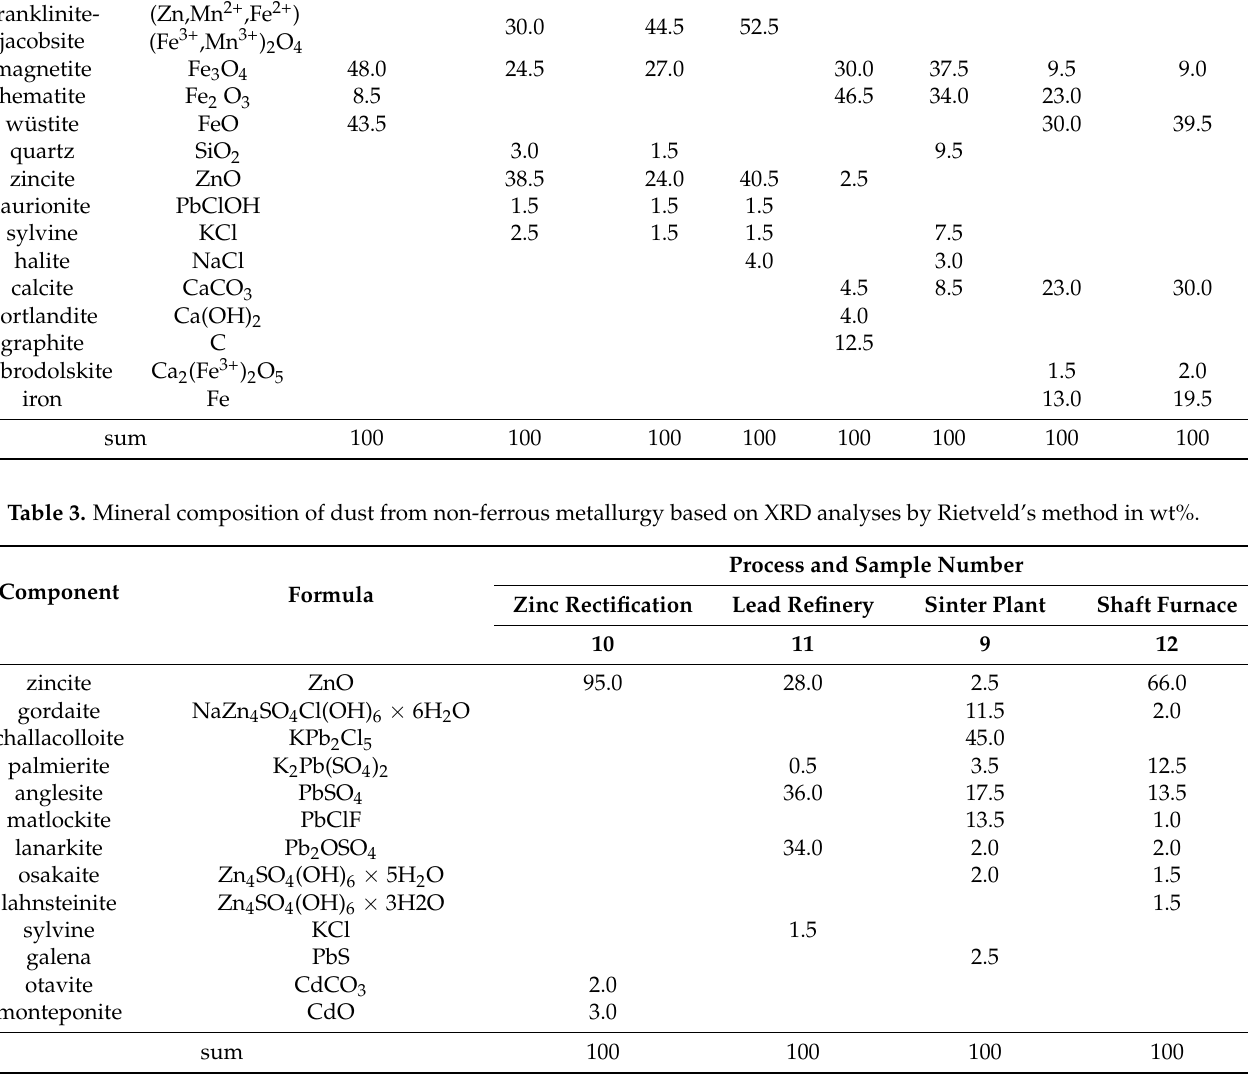
Sinter De-Dusting Iron-Bearing Sludge Steel Dust Dust dust